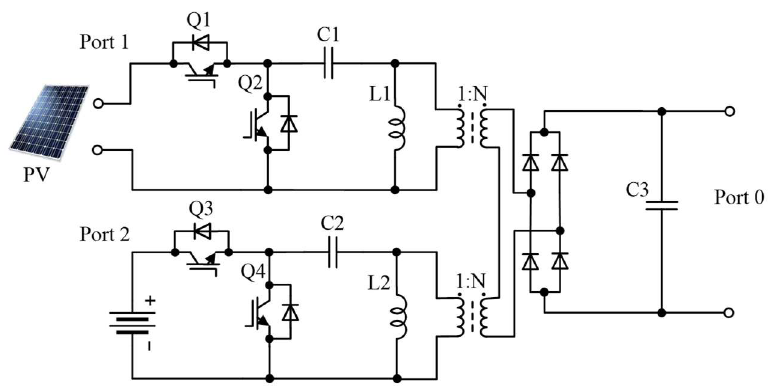
Figure 16. Isolated Three-Port CLL- Resonant Converter [75]. Table 2. Summary of hybrid